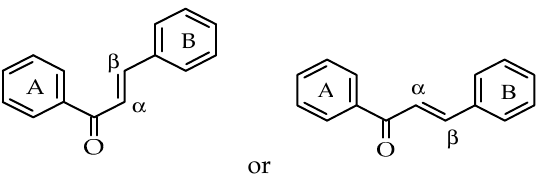
Figure 1. General structure of chalcones.